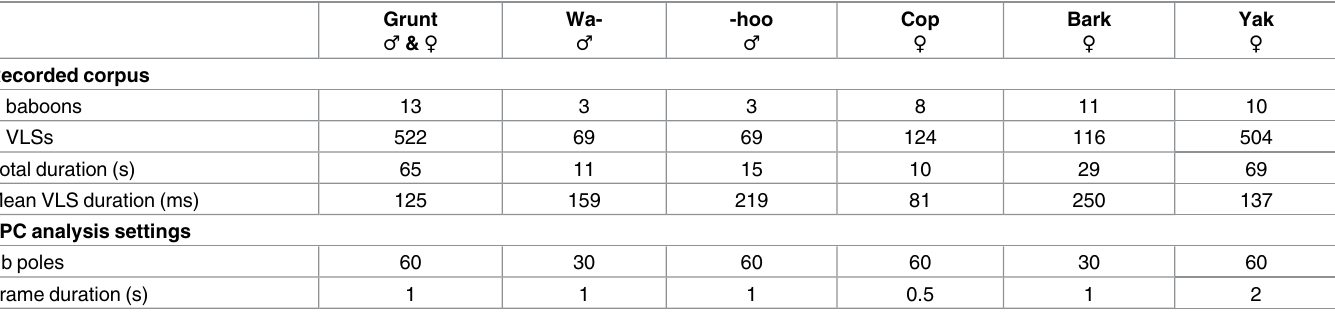
Table 1. Recorded corpus characteristics and LPC